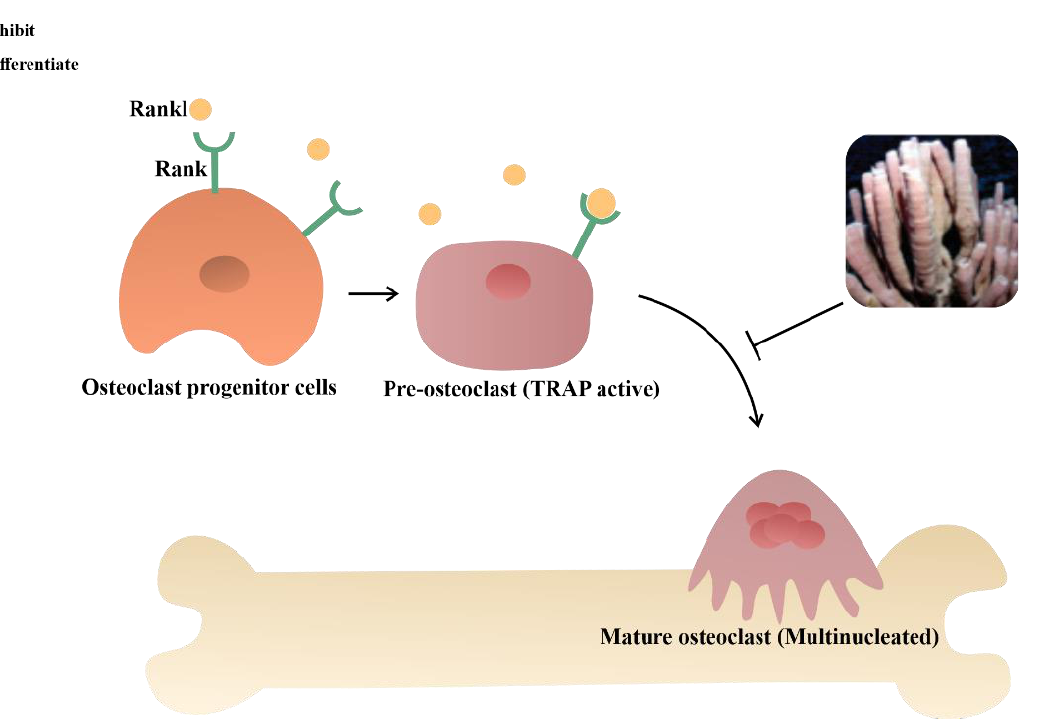
Figure 12. Antiosteoporotic mechanisms of Neviotine A and D from the Callyspongia siphonella .